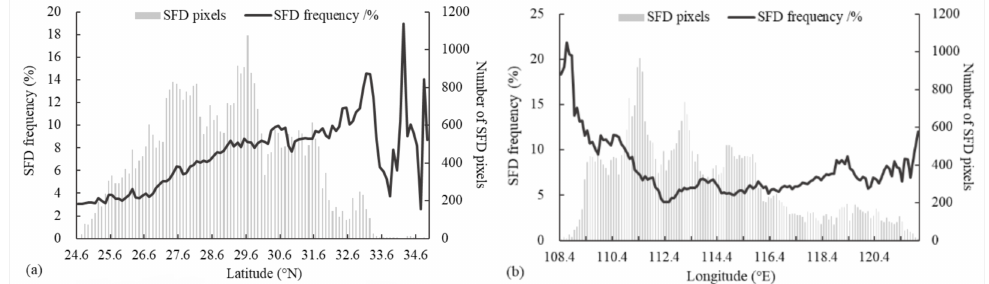
Figure 10. The frequency (black line, left y -axis) and pixel numbers (gray bars, right y -axis) of pixel-based spring frost damage (SFD) for tea plants as influenced by latitude ( a ) and longitude ( b ) at 0.1 ◦ intervals from March to April in 2003–2020 in the middle and lower reaches of the Yangtze River region, China.